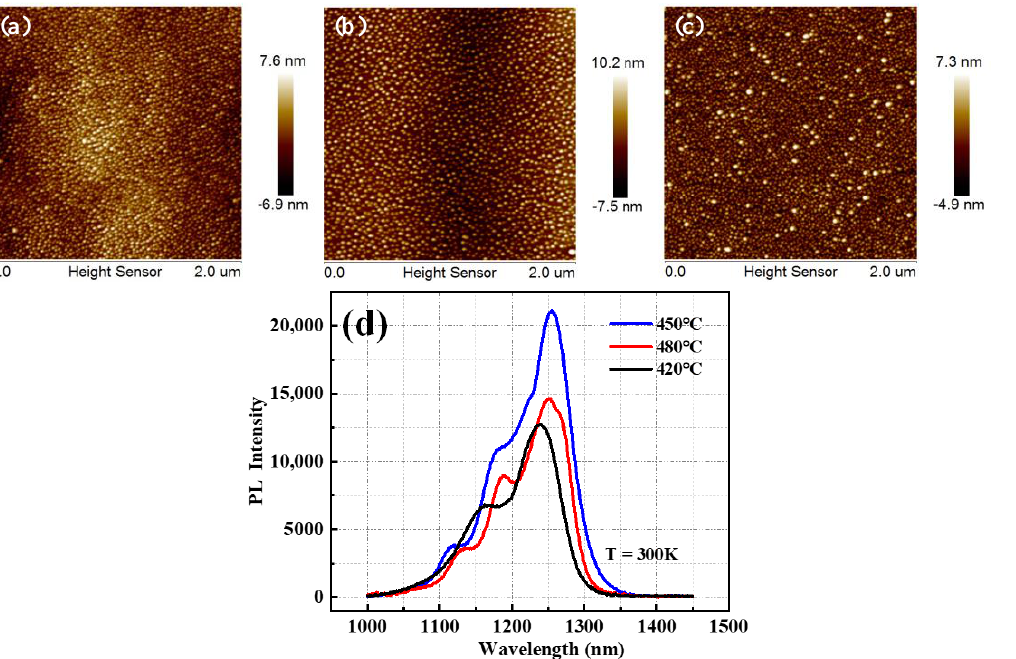
Figure 8. ( a – c ) AFM images of InAs QDs grown on the GaAs/Ge/Si substrate at 0.1ML/s with the same deposition thickness of 3.1ML but different temperatures: 420 °C, 450 °C, and 480 °C, in sequence; and ( d ) room-temperature photoluminescent spectra of InAs/GaAs QDs grown at the aforementioned growth temperatures.